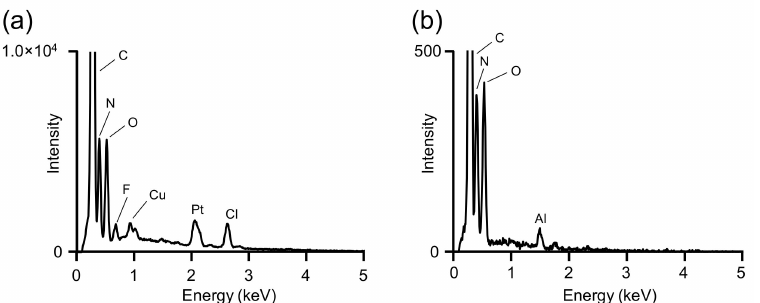
Figure 4. EDX spectra for heat-stretched regenerated silk fibroin (RSF) fibers with/without washing using methanol to confirm the remaining ionic liquid. The RSF fiber ( a ) without washing and ( b ) with washing using methanol. The peaks of copper, platinum, and aluminum in the picture are backgrounds from sample holders or sputter deposition in sample